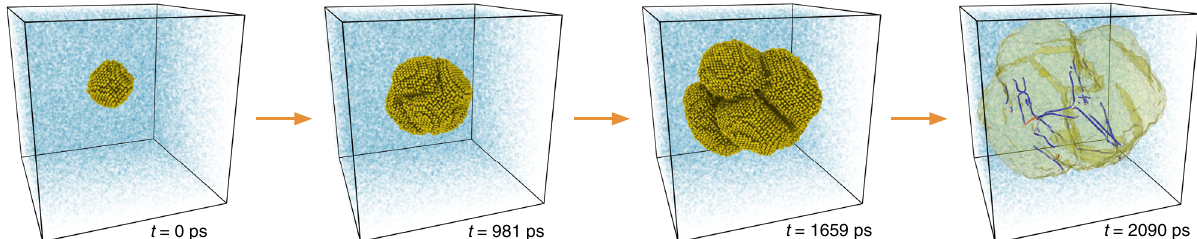
Fig. 1 Crystal growth simulations. Snapshots of a crystal growth simulation of silicon using molecular dynamics. The system initially contains a small crystalline seed (yellow atoms) surrounded by liquid (transparent blue atoms). Shown in the last frame is the dislocation network 46,62,63 formed during the growth process (edge dislocations are colored blue while screw dislocations are shown in red). See Supplementary Video 1 for the complete video and Supplementary Video 3 for dislocation network